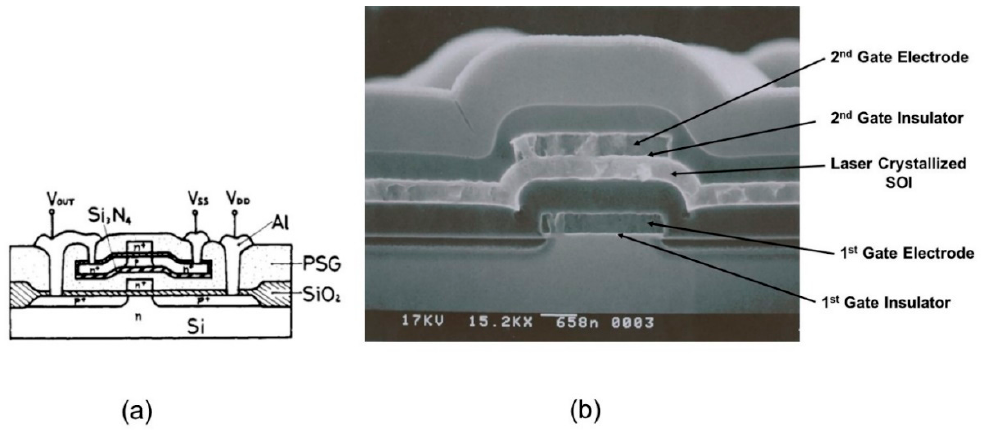
Figure 1. The first fabrication of monolithic three-dimensional integrations (3D IC). The n-MOS silicon on insulator (SOI) transistor is stacked over bulk p-MOS transistor. ( a ) Schematic illustration of the 3D inverter. ( b ) Cross-sectional SEM view. After Sasaki et al. [5].